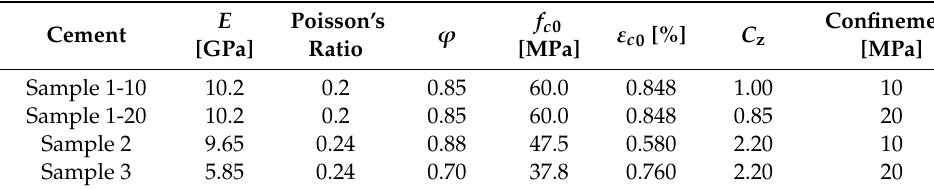
Table 2. Parameters of the model used in numerical simulation.